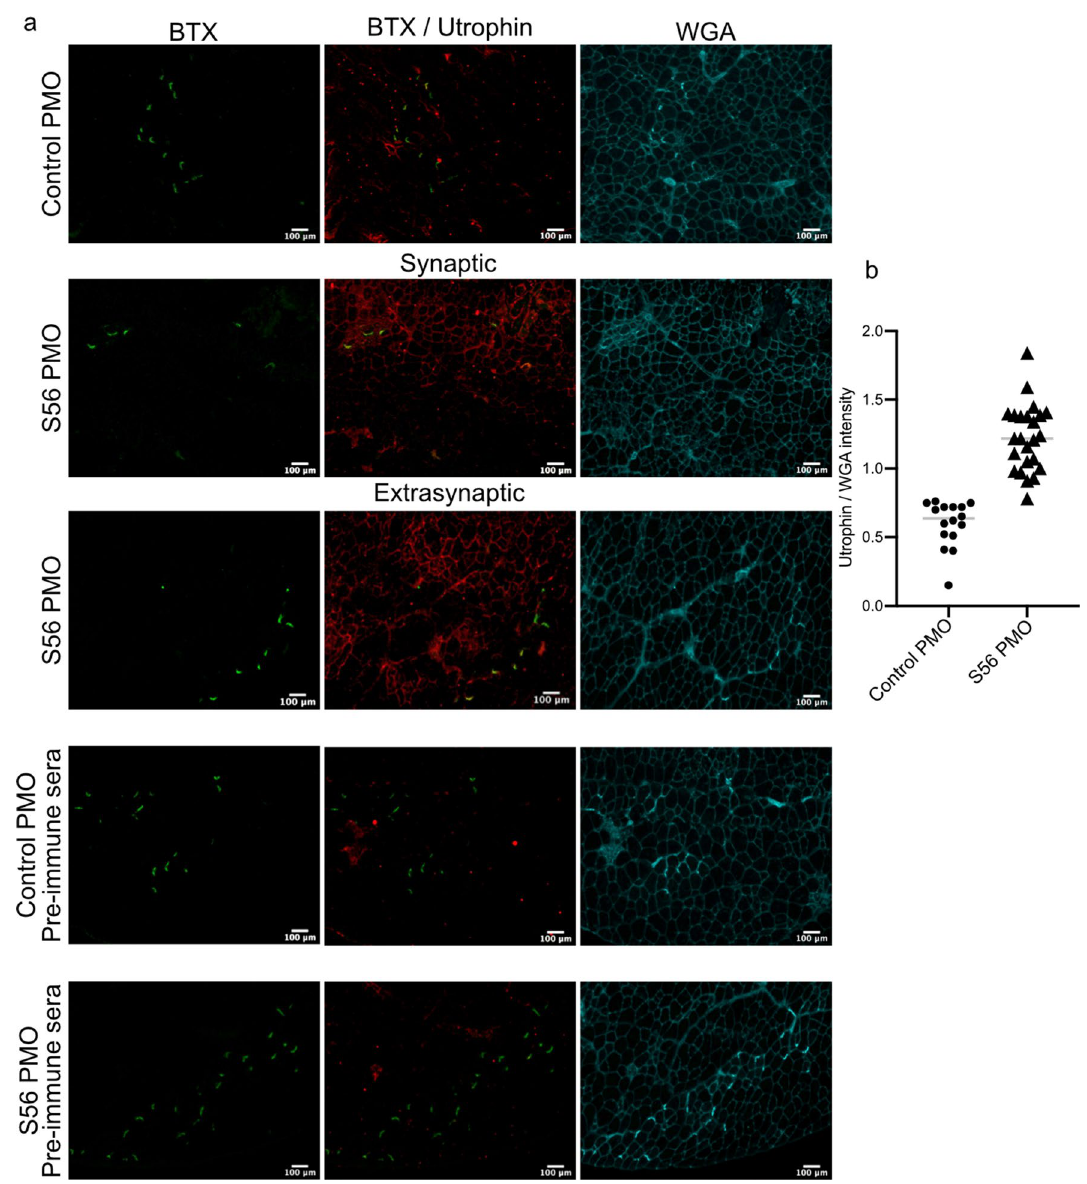
and wheat germ agglutinin (cyan). The control PMO and S56 PMO treated cryosections were also stained with utrophin pre-immune sera as control. Scale bar = 100 µm. The figures showed synaptic expression of utrophin in control PMO, and both synaptic and extra-synaptic sarcolemma associated expression of utrophin in S56 PMO treated mice. ( b ) Quantification of utrophin expression in sarcolemma normalized with WGA expression. S56 PMO treated muscles showed significantly higher expression of utrophin (**** p = 0.0001, n = 4 mice for both groups). Statistical analysis performed by Mann–Whitney nonparametric